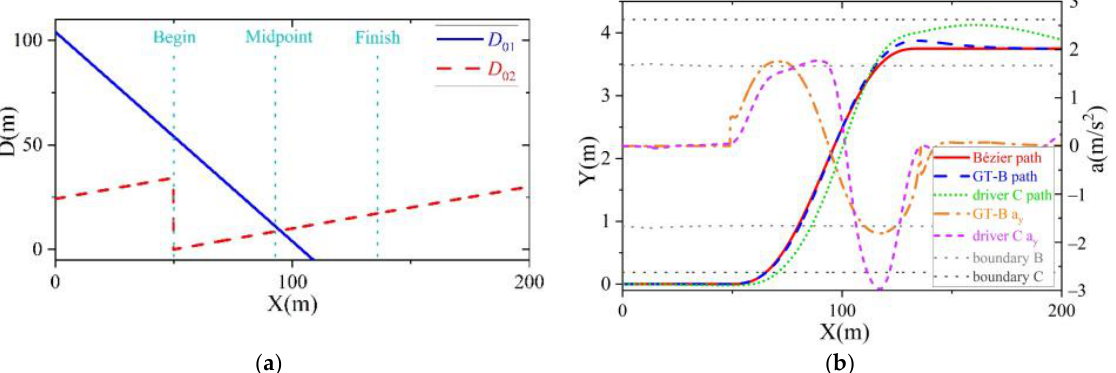
Figure 15. Vehicles’ interval, path and lateral acceleration in Case III. ( a ) Relative distance between other vehicles and Car . 0; ( b ) Vehicle path and lateral